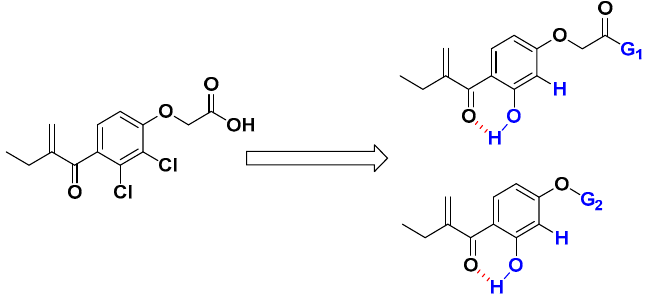
Figure 1. Chemical modification to improve the electrophilic character of the Michael acceptor of EA analogs.